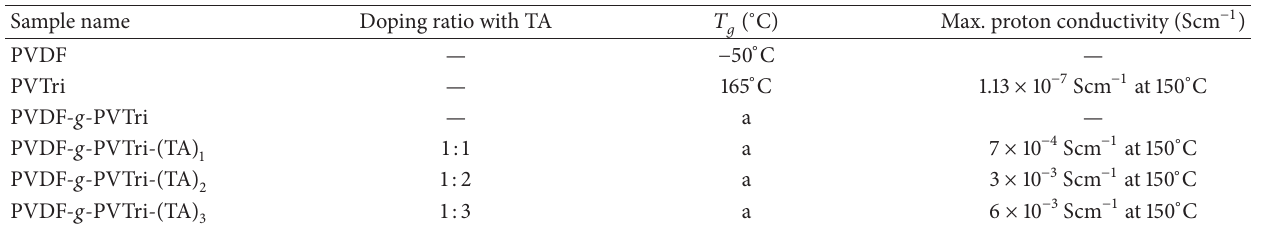
Table 2: Doping ratio with TA and 𝑇 𝑔 and maximum proton conductivity values of PVDF based membranes.